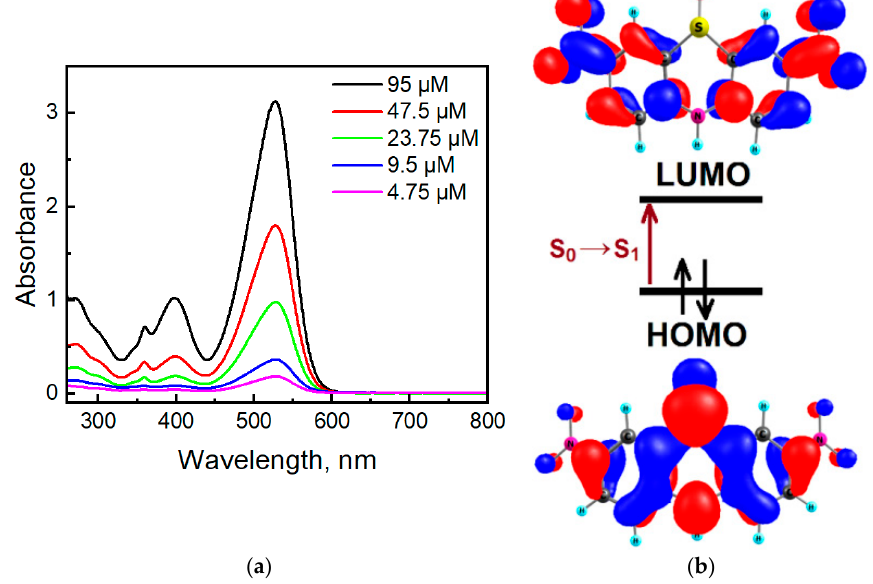
Figure 13. Absorption spectra of compound 3 in DMSO ( a ) and orbital diagrams for compound 3 calculated at the B3LYP/6-31G(d,p) level of theory ( b ). Compound 3 shows a fluorescent band located at 647 nm (Figure 14). The phenothi- azine S -oxide or its N -alkyl analogs exhibit fluorescence in the 350–450 nm region [56,57]. For molecule 3, TDDFT calculations indicate the observed emission band at 647 nm as the S 1 → S 0 transition calculated at 568 nm (Table S2). Two electron-withdrawing nitro groups remove the electron density from the sulfur atom and decrease the LUMO energy, and the emission band of dinitrophenothiazine S -oxide is red-shifted by 200 nm. Moreover, molecule 3 shows a large Stokes shift (122 nm), which indicates that the geometry of the singlet excited state differs from the geometry of the ground state. In the S 0 state of mole- cule 3, the bending angles in the middle phenothiazine ring denoted as Θ S and Θ N were calculated to be 95.08° and 122.78°, respectively, while in S 1, these angles are 104.50 and 127.27 (Figure S4, SI). Much larger distortions are calculated in the C-N and C-S bond lengths upon the S 1 → S 0 transition (Figure S4) according to the strong differences in the bonding-nonbonding characters of the frontier orbitals (Figure 13b). Typical distortions also occur in the nitro groups since LUMO is bonding for the C-N links and anti-bonding for the N-O chemical bonds.